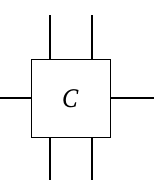
Figure 2: The same network is shown as in Figure 1 after contracting A and B along their shared edge.